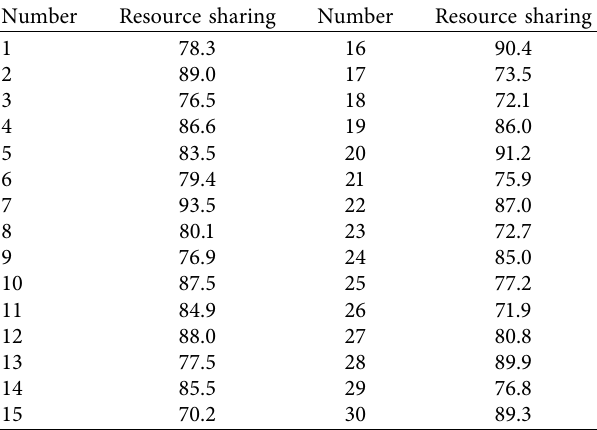
Figure 9: Statistical diagram of the effect of deep learning in the processing of online teaching resources of spoken English. Table 2: Evaluation of the online teaching resource sharing system of spoken